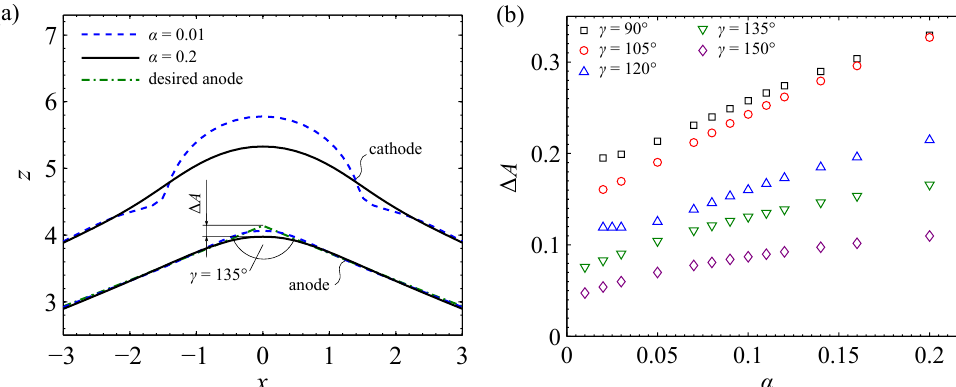
Figure 13. Anode shapes produced by regularized cathodes (spatial dimensions are normalized to the width of the standard equilibrium front gap). ( a ) The prescribed anode (dash-dotted line) has an opening angle of γ = 135 ◦ . The panel shows details of the anode around x = 0 and z = A with ∆ A exemplarily denoting the difference in the amplitude of the computed anode from the nominal value A . ( b ) The values of ∆ A obtained from the numerical computation at different angles γ are illustrated by the